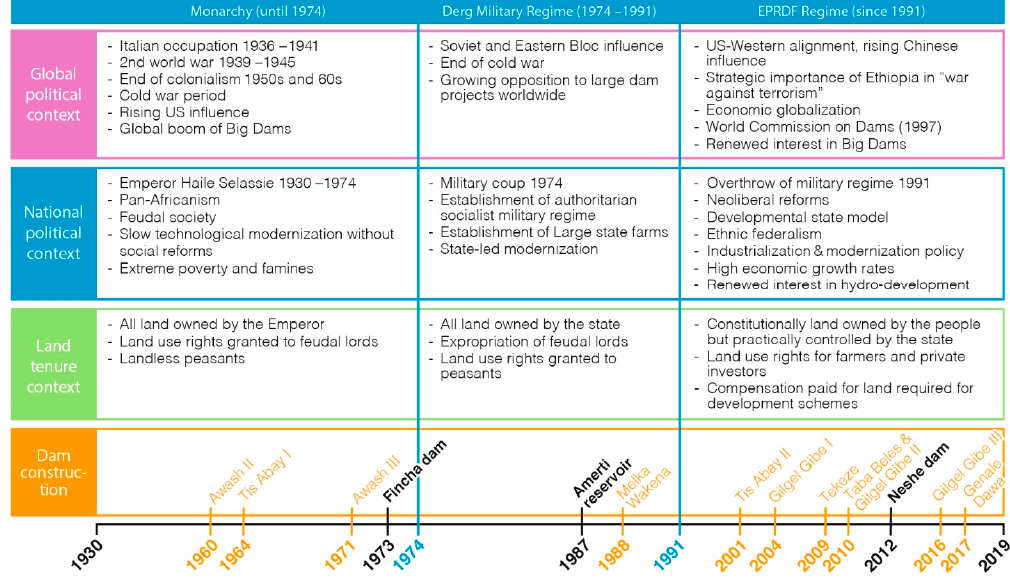
Figure 2. Timeline of Ethiopian hydro-development 1930 to